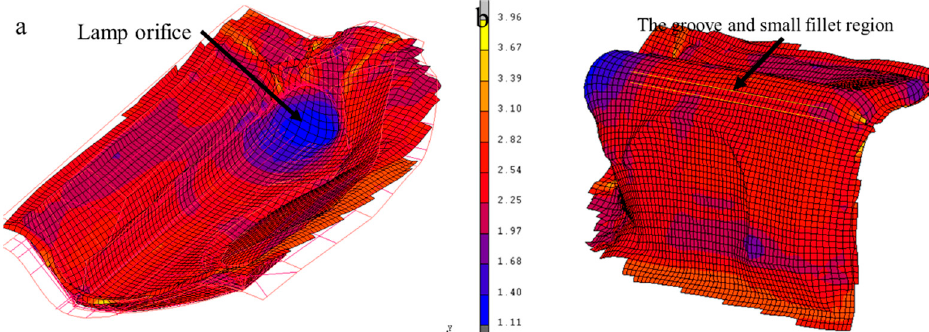
Figure 13. Thickness distribution of superplastic forming (SPF) during the final forming process. ( a )interior perspective; ( b ) lateral perspective